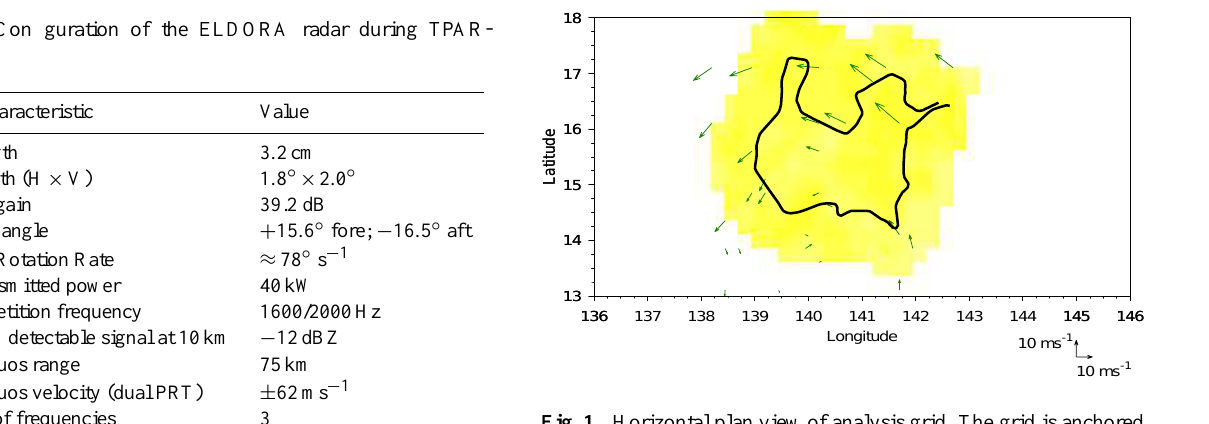
Fig. 1. Horizontal plan view of analysis grid. The grid is anchored to the storm, which is moving with velocity ( − 9.0,0.8) ms − 1 . The axes are longitude and latitude at the reference time, 00:55:00UTC on 17 August 2008. The grid extends from the surface to 20km with a vertical grid step of 0.625km. The horizontal grid steps are 0.25 ◦ . The aircraft track flown during the radar collection time is shown, along with the winds from dropsondes, The aircraft and dropsonde positions have been re-navigated to the co-moving grid. The scales for the zonal and meridional winds are shown at the bottom of the plot. Regions where reflectivity exists at an altitude of 2.5km are shown in